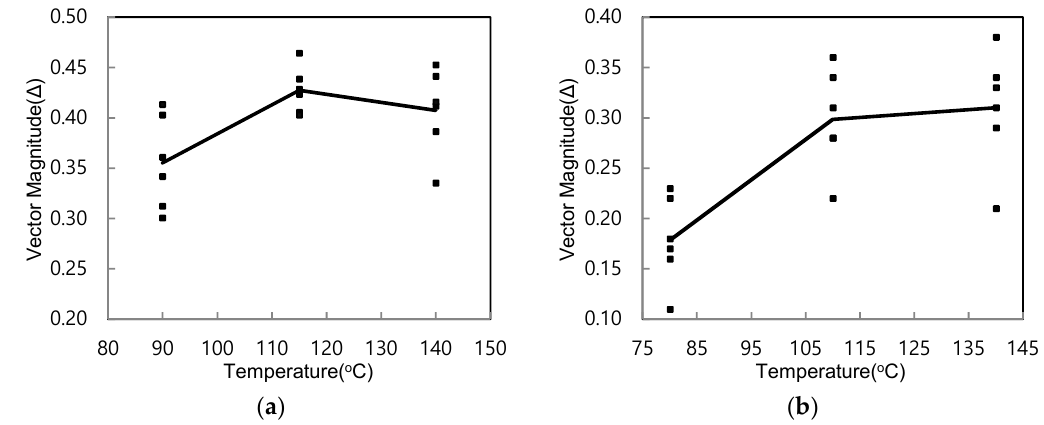
Figure 9. Variations of ∆: ( a ) PG64-28 mixtures; ( b ) PG58-28 mixtures.